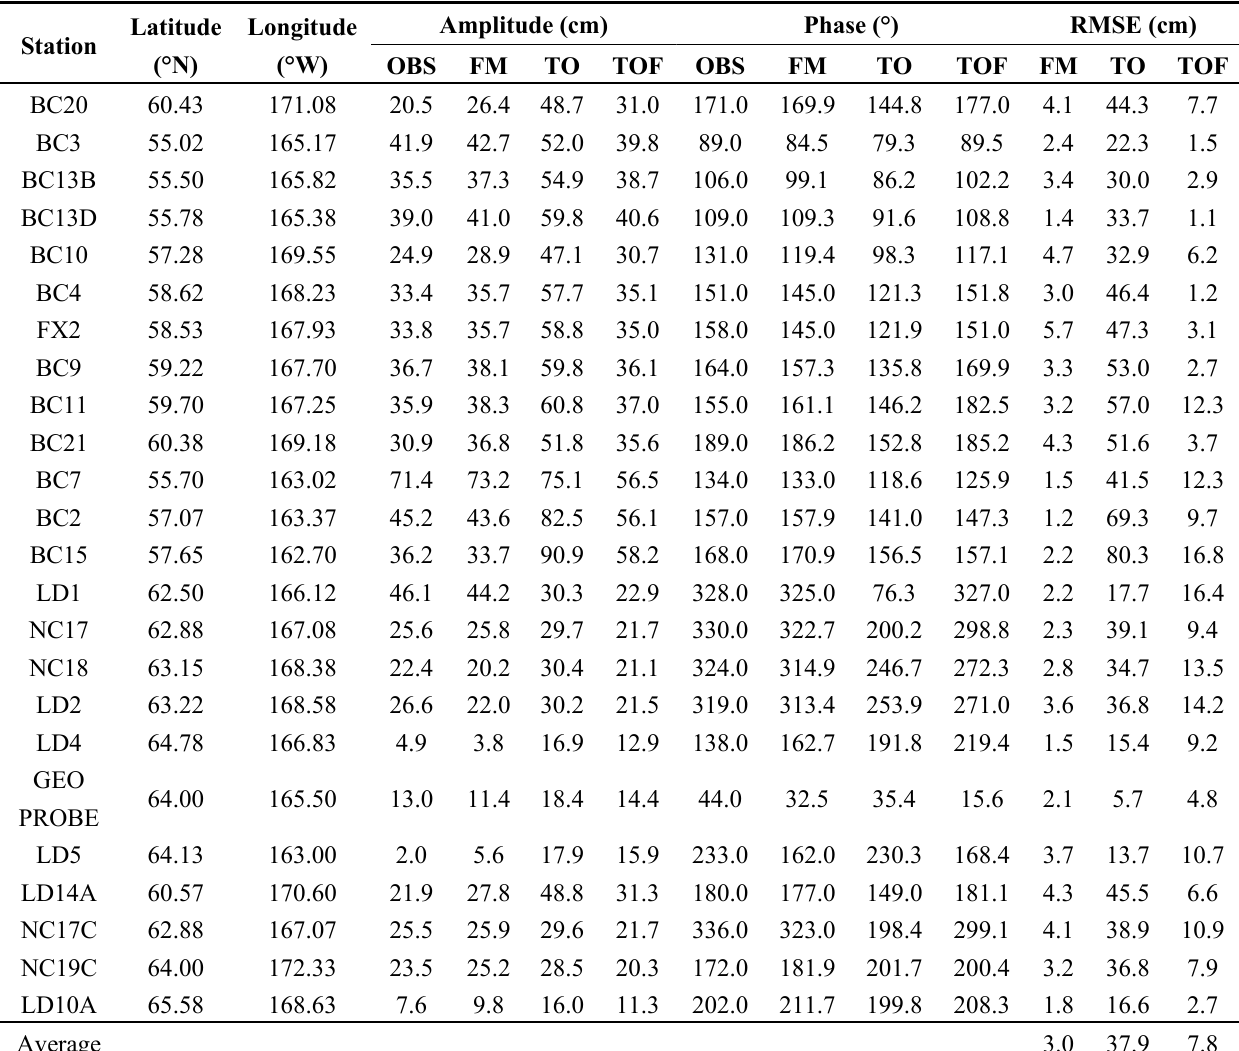
amplitude and phase at the literature stations between 2